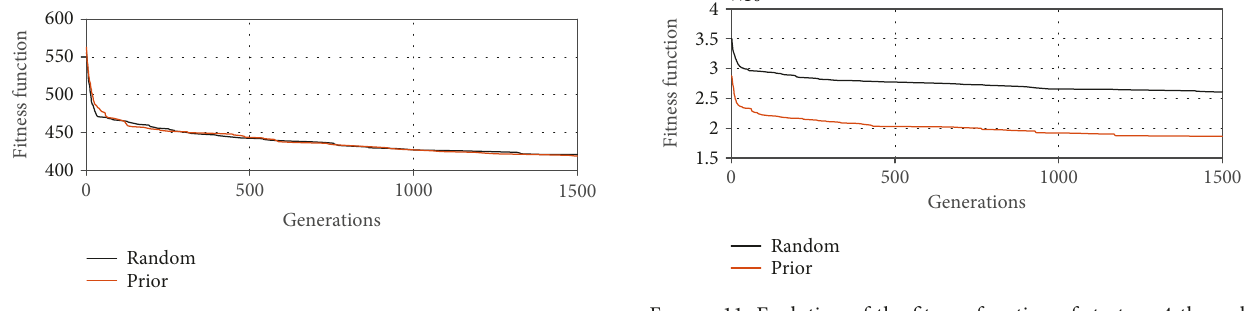
Figure 8: Evolution of the fi tness function of strategy 1 through generations.